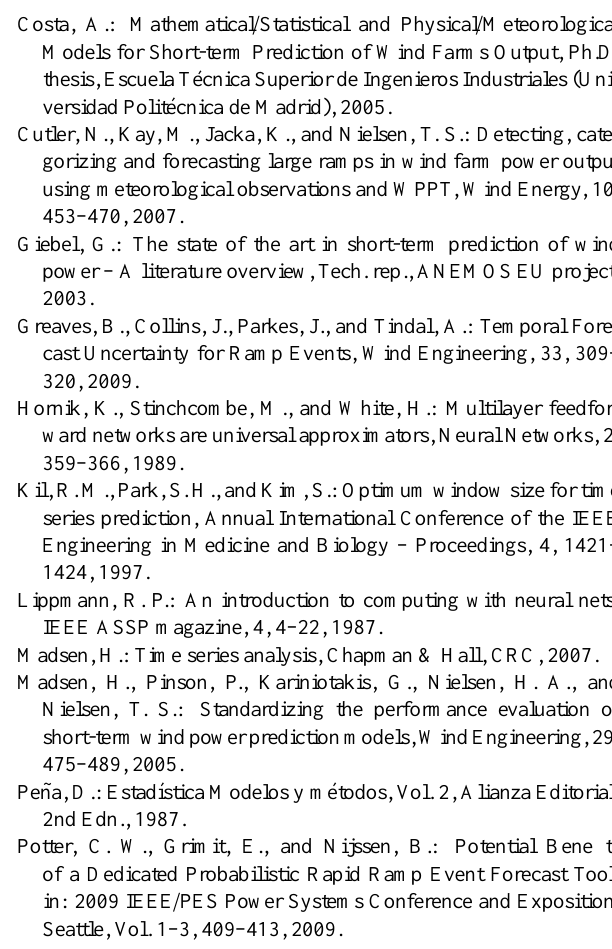
Table 1. IoP% for the case of one-hour ahead